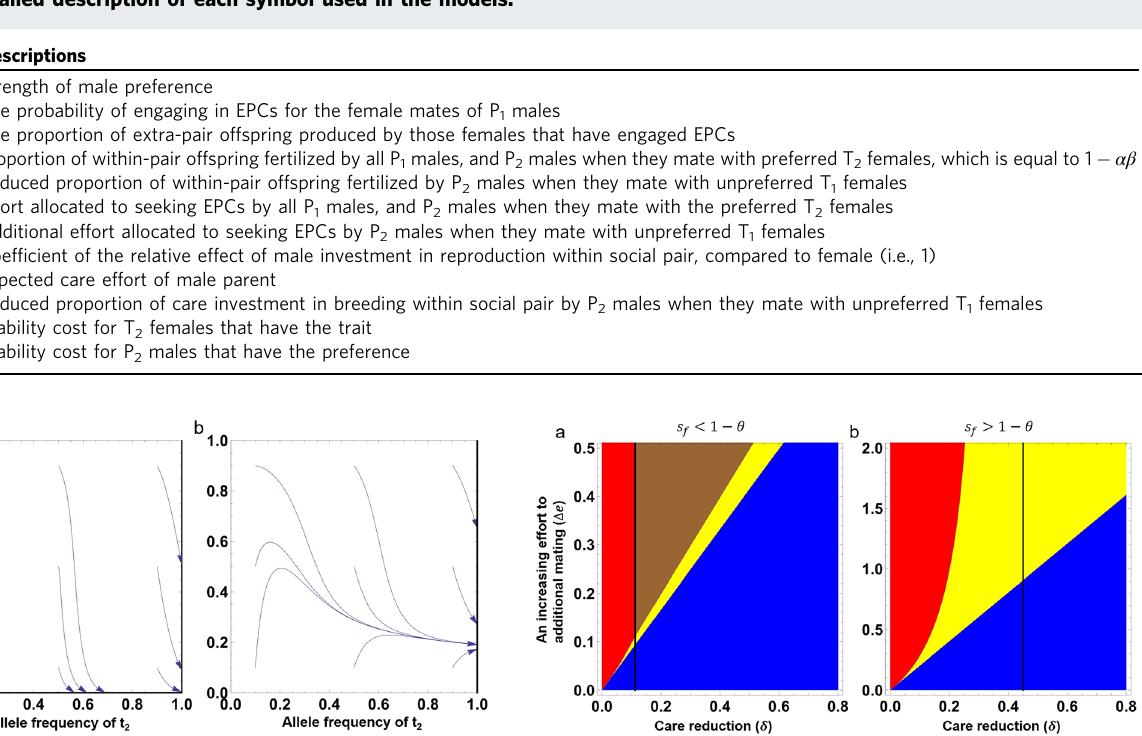
satis fi ed) represents the conditions for a stable polymorphic equilibrium.